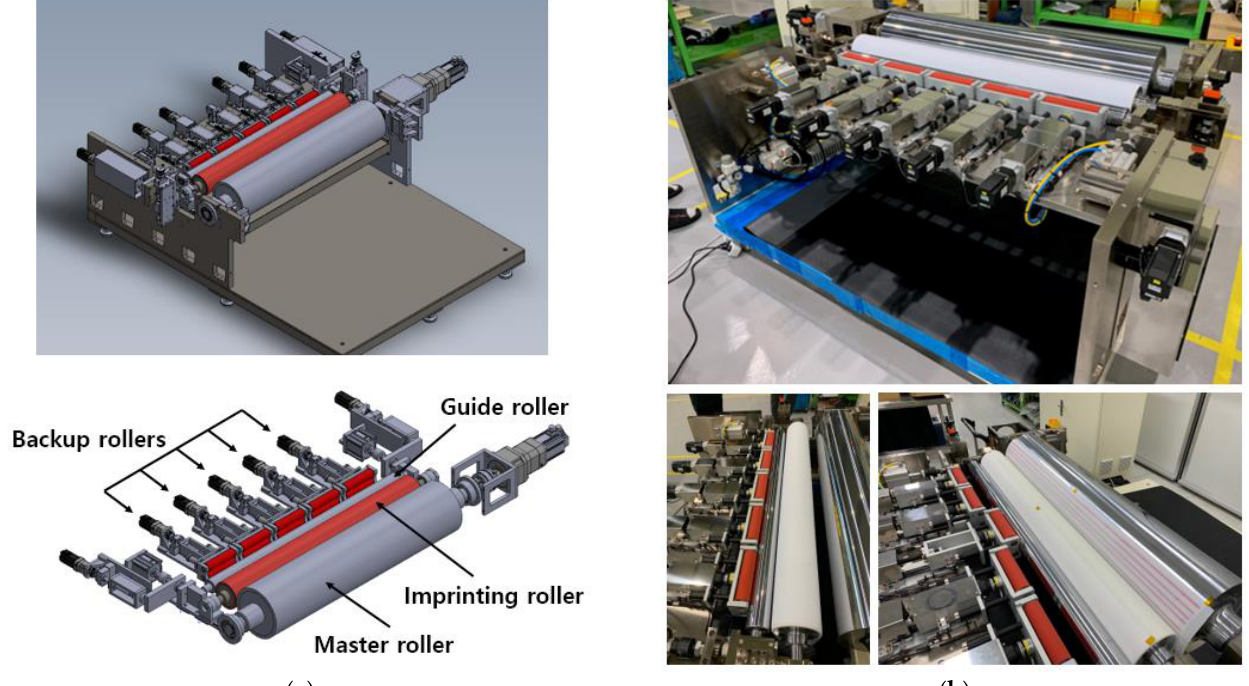
Figure 5. Large-area R2R uniform pressing system capable of independent pressing: ( a ) Design of large-area R2R uniform pressing system; ( b ) Appearance of large-area R2R uniform pressing system.